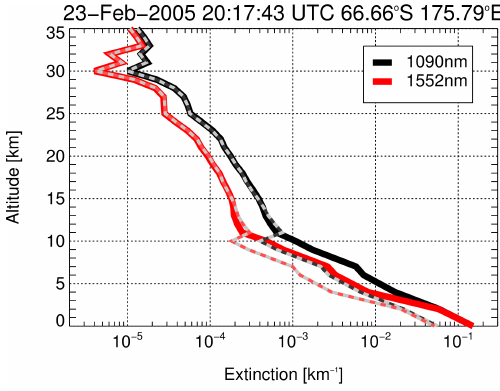
Figure 2. Aerosol extinction profiles for V3 (dashed lines) and V3.01 (solid lines) for the two wavelength used in the aerosol re- trieval (1090nm black and grey line, 1552nm red and orange